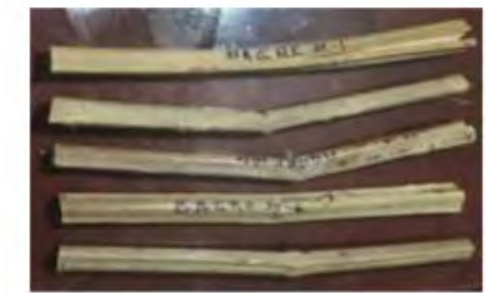
Figure 24. The Failure Pattern in the specimens (Author’s own, n.d.)